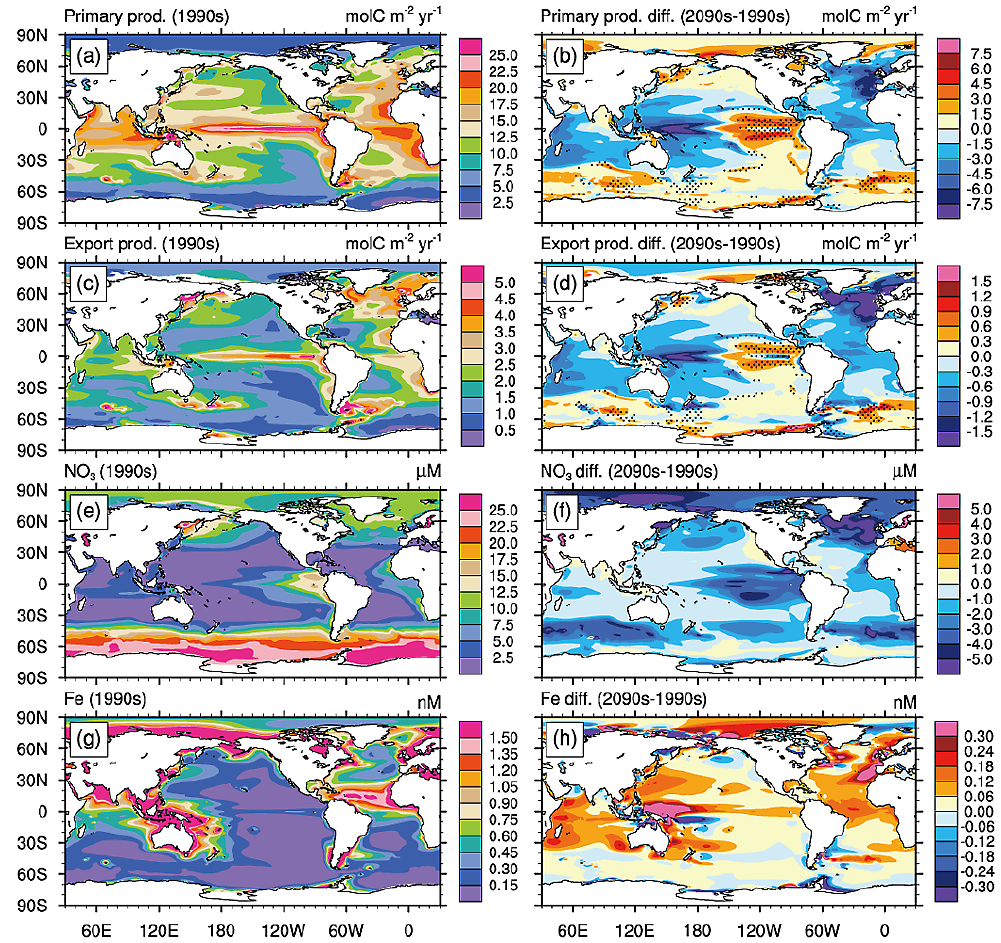
Fig. 3. Spatial distributions of simulated primary production (mgCm − 2 day − 1 ) ( a and b ), export production (mgCm − 2 day − 1 ) ( c and d ), NO 3 (µM) ( e and f ) and Fe concentrations ( g and h ) averaged over the upper 100m (nM) in the 1990s ( a , c , e and g ) and their differences between 2090s and 1990s ( b , d , f and h ). Dotted regions in panels (b) and (d) show the IRON-DRIVEN AREA, discussed in Sect.